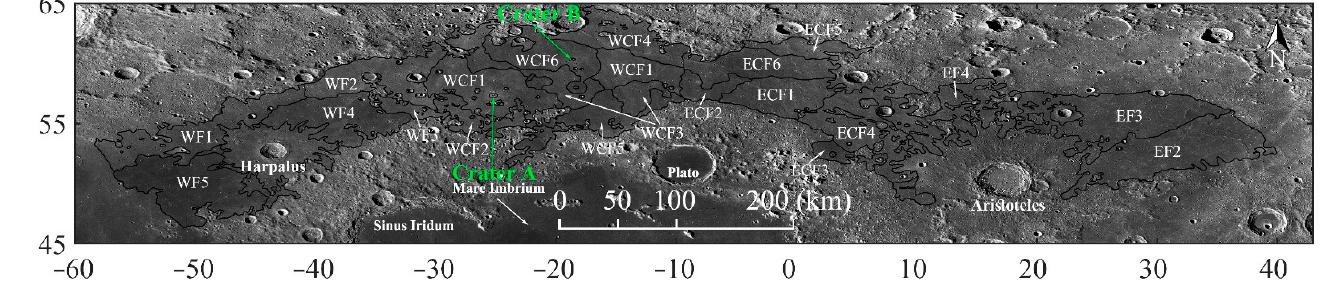
Figure 1. A wide-angle camera image of Mare Frigoris from the Lunar Reconnaissance Orbiter Camera (Equidistant Cylindrical projection), which was downloaded from https://wms.lroc.asu.edu/lroc/search (accessed on 20 June 2010). The black lines are the geologic boundaries and the abbreviations marked WCF5 in the west to EF2 in the east are the basaltic units of Mare Frigoris mapped by Kramer et al. [2]. The geologic boundaries were vectorized from the geologic map provided by Kramer et al. [2] and overlaid on this map and the following Figures 3– 7, 9, 15, and 16. Crater A and Crater B are the two craters with brightness temperature anomalies, as discussed in Sections 3.2.2 and 4.2.1.